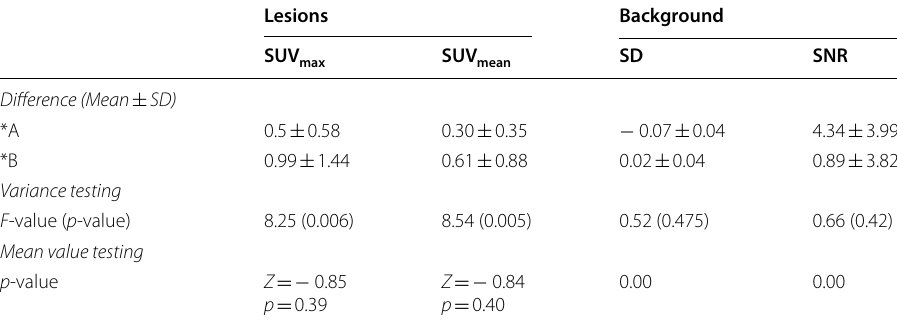
*A and *B represented the differences of the reconstruction of full data without respiratory gating and multi-bins respiratory gating relative to the reconstruction of first 3 min and 20 s of data, respectively